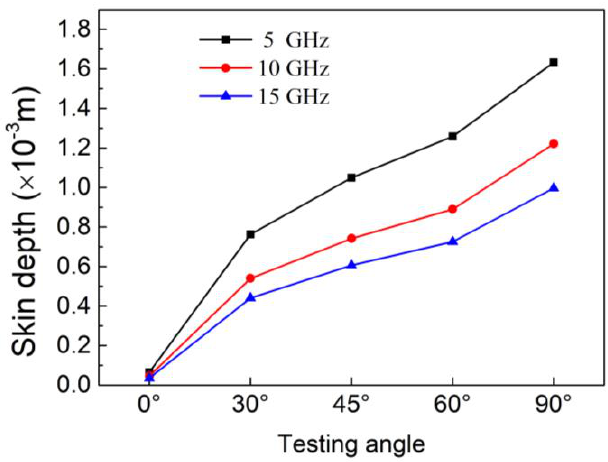
Figure 4. Skin depth of CFRP as a function of testing angles.